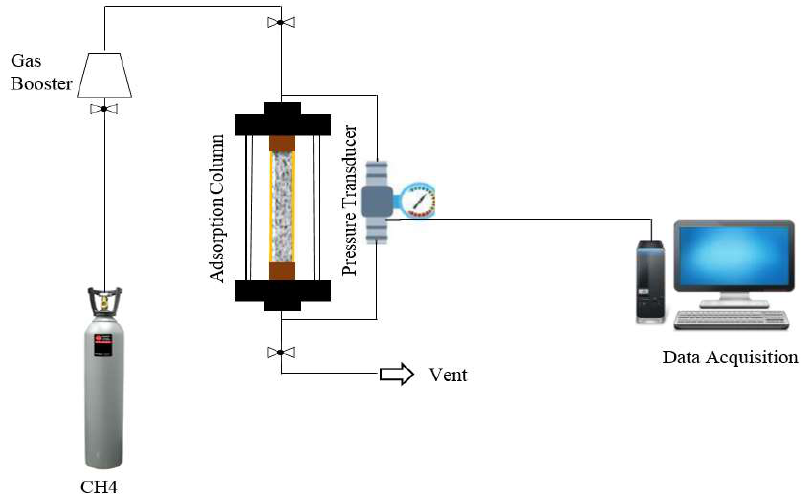
Figure 3. Schematic of Adsorption/Desorption Experimental Set-up.